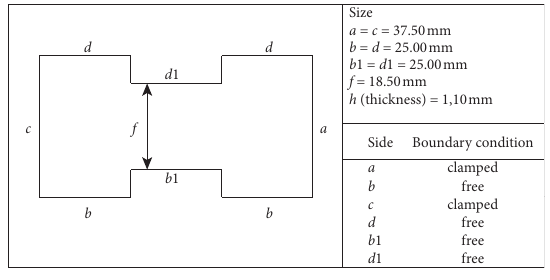
Table 15: Geometrical properties and boundary conditions (Case 4).